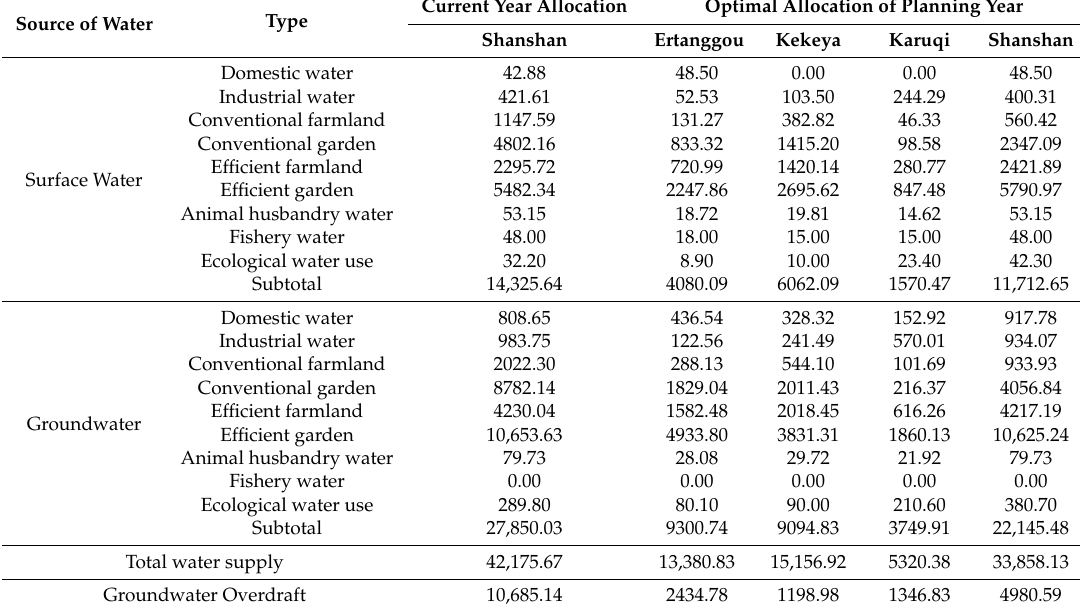
Table 3. Supply and demand balance table for current and planned years in Shanshan under 50% frequency (10 5 m 3